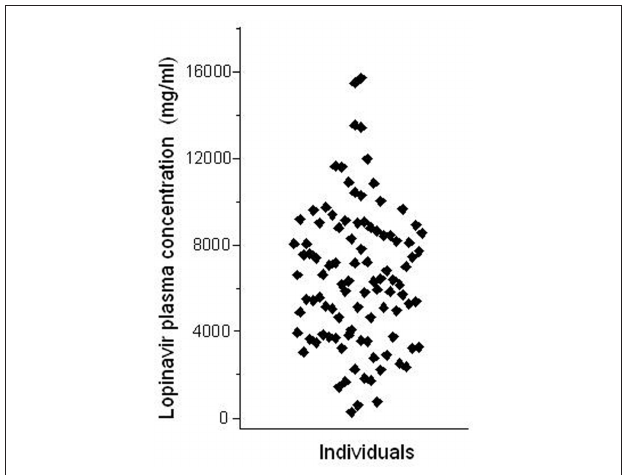
FIgure 3 | Intra-individual variability of lopinavir pharmacokinetics. The plot shows the trough (pre-dose) concentration of lopinavir in the plasma of 99 HIV-infected males, under stable HAART treatment including two daily doses of lopinavir (400 mg) and ritonavir (100 mg). Each data point corresponds to one individual. Data from Estrela et al. (2009).